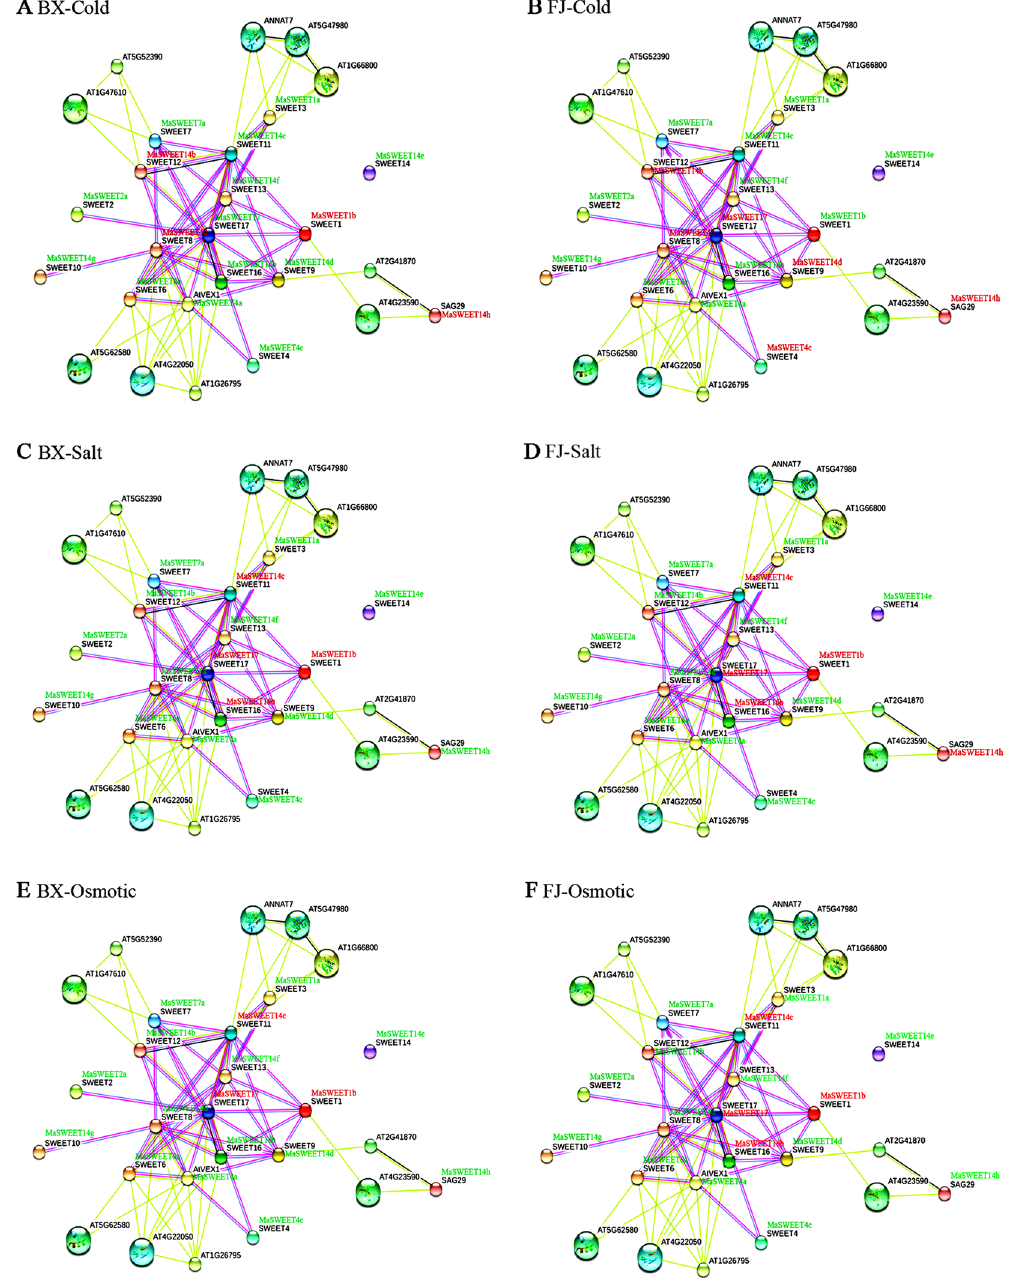
Figure 10. Interaction network and co-expression analyses of MaSWEETs under cold ( A , B ), salt ( C , D ), and osmotic ( E , F ) stresses in BX and FJ banana varieties and related genes in Arabidopsis . Line thickness relates to combined score. Genes marked in red show upregulation in BX and FJ. Genes marked in green show downregulation in BX and